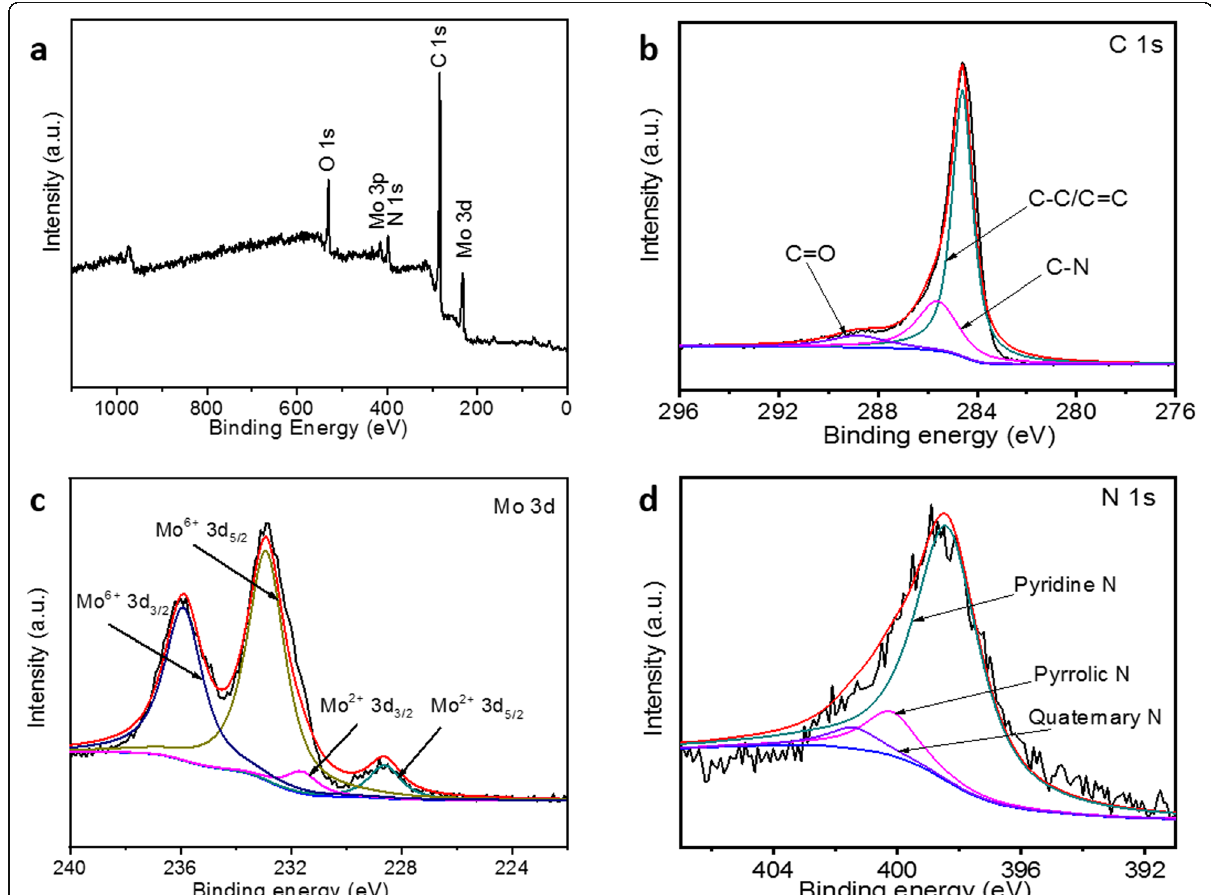
Fig. 4 XPS survey spectrum ( a ) and high-resolution XPS scan of C1s ( b ), Mo3d ( c ), and N1 s ( d ) of Mo 2